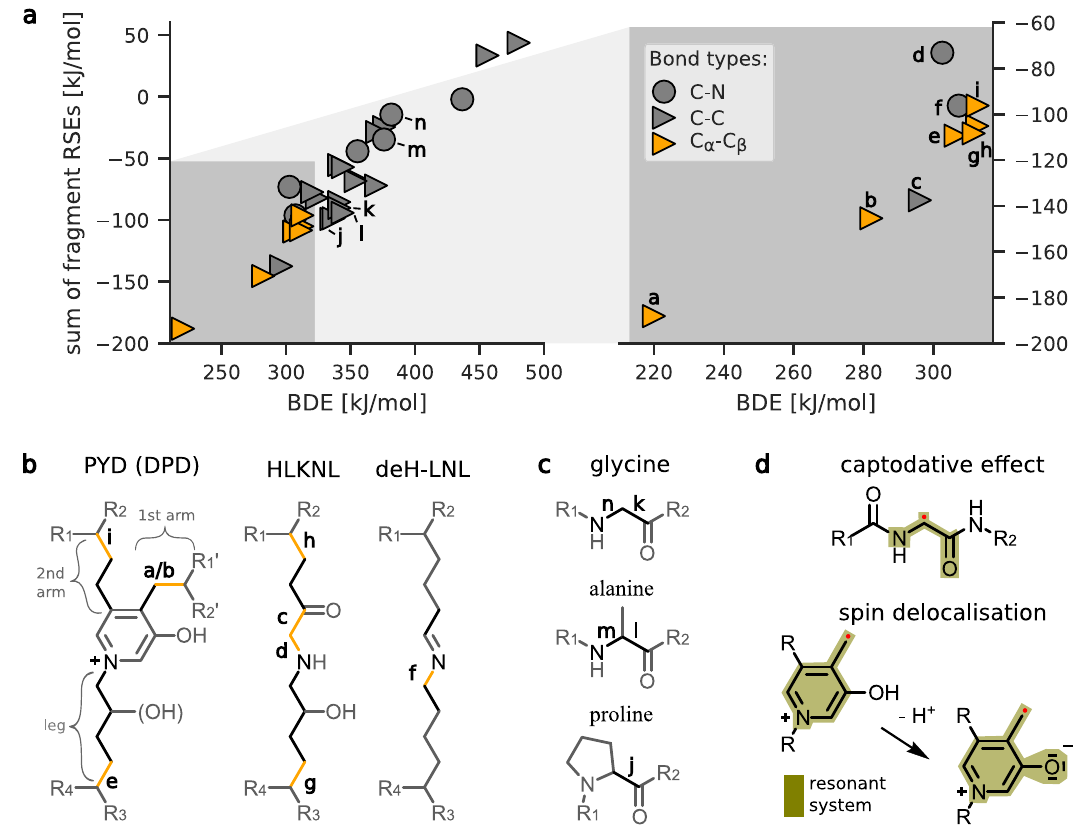
Fig. 2 | Crosslinks harbor the weakest bonds in collagen type I. a Correlation between the bond dissociation energies (BDEs) and summed radical stabilization energies(RSEs)ofhomolyticallycleavedbondsandformedradicals.Allmolecular structures used for calculations can be found in the SI. Bonds with BDEs <315kJ mol − 1 areshowninmoredetailontheright.Thesmalllettersclosetoselecteddata points indicate respective bonds in the lower panels b and c . b , c Molecular structures of ( b ) investigated collagen crosslinks and ( c ) prevalent aminoacids in collagen. BDEs of bonds colored in black and orange (BDE <315kJmol − 1 ) were